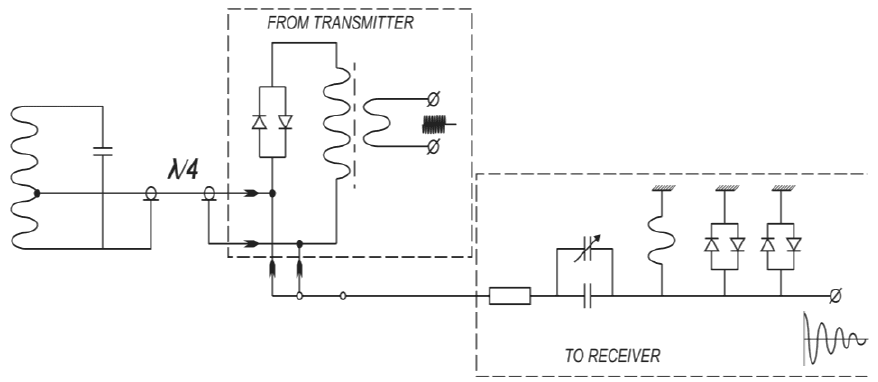
Figure 3. Principle electric scheme of the spin-echo signals transitions to/from RF coil.